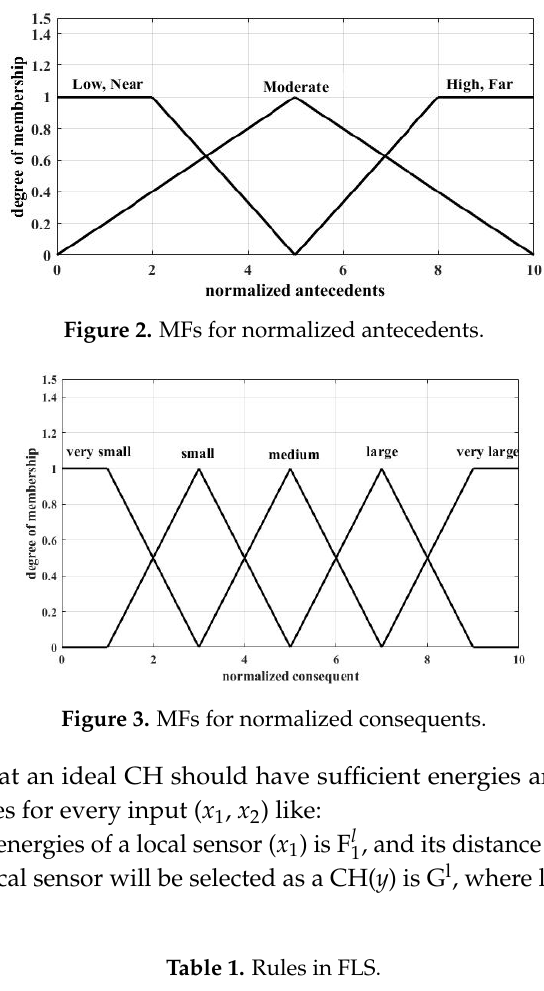
Table 1. Rules in Table 1. Rules in FLS. Table 1. Rules in FLS.